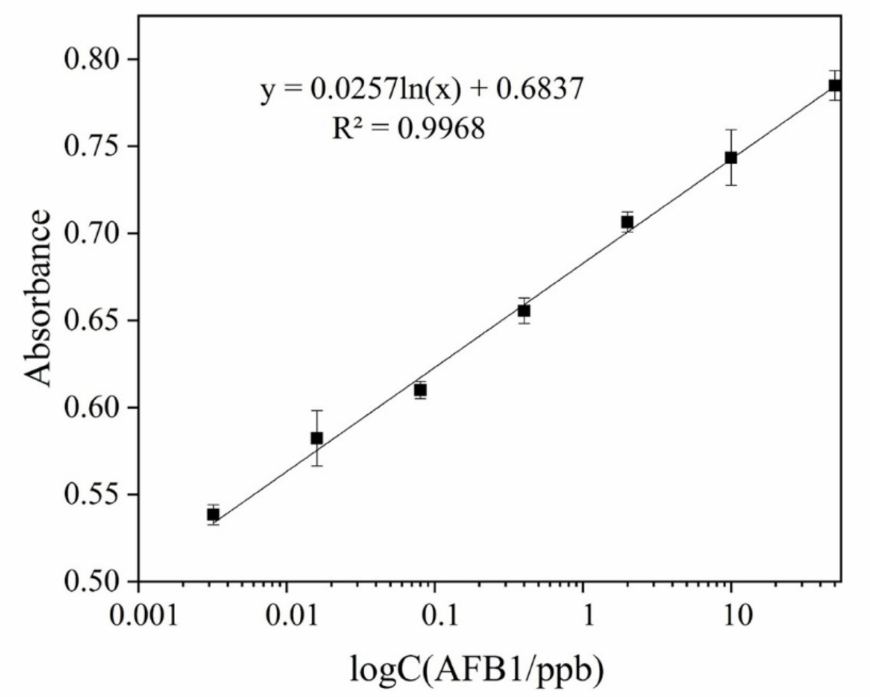
Figure 5. Linear relationship between the colorimetric signal and concentration of AFB1 on logarith- mic scales. Each data point represents an average of 3 measurements (each error bar indicates the standard deviation).